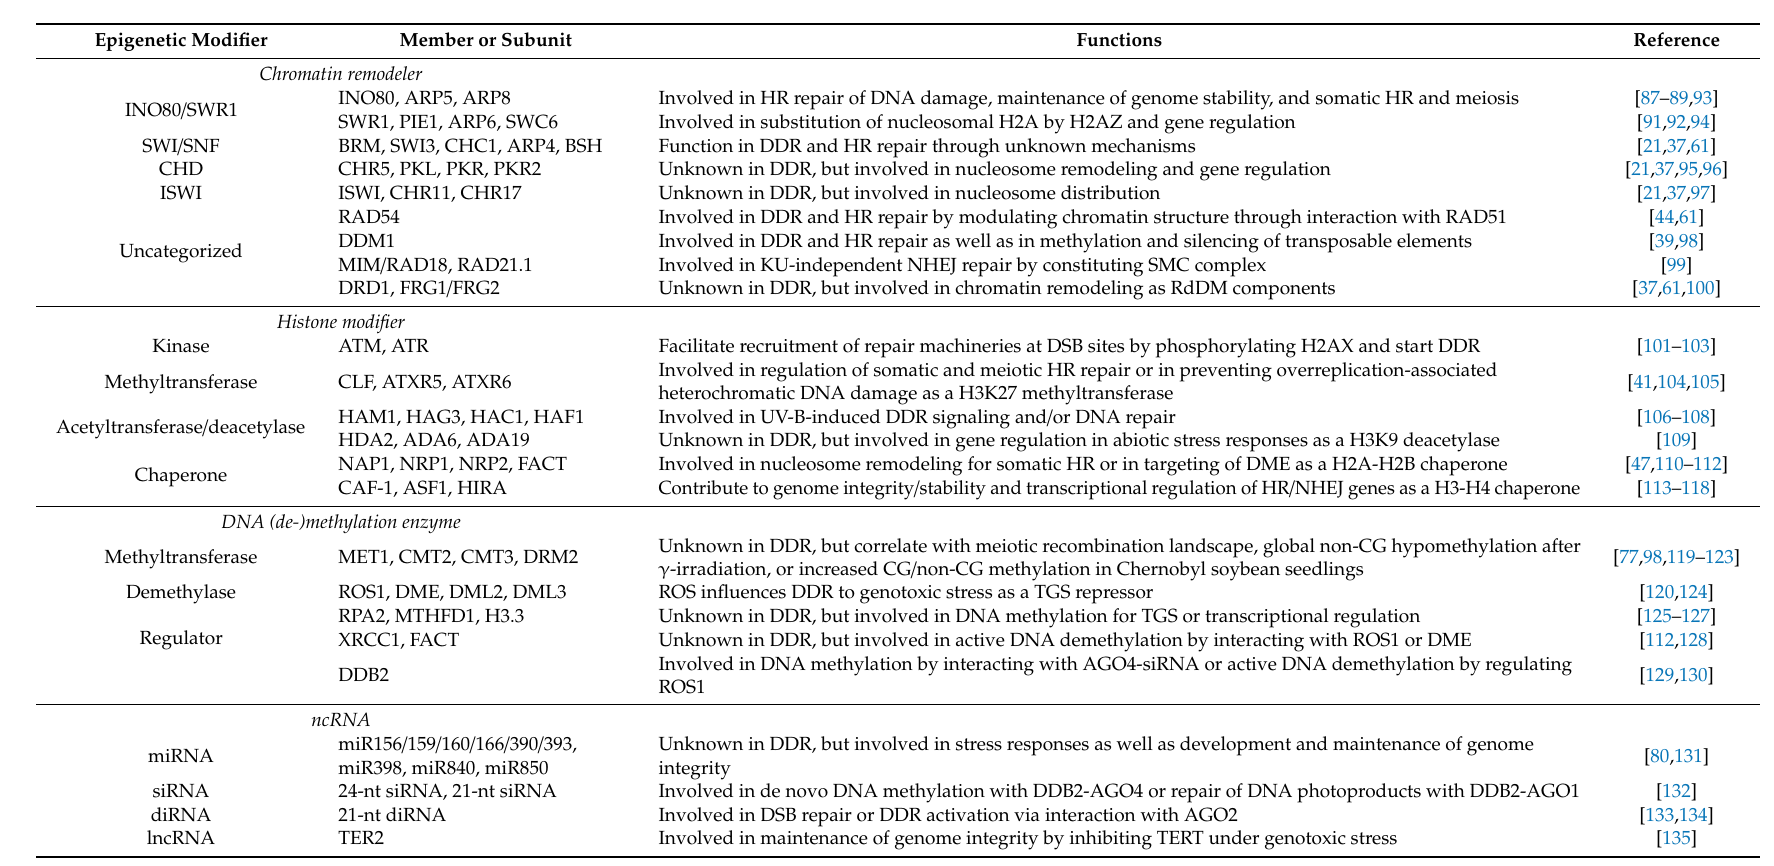
Table 2. Epigenetic modifiers in plant DDR and DNA repair. This summarizes the representative examples for each epigenetic modifier in correlation with DDR or DNA repair in plants. ‘Unknown in DDR’ means that there is no evidence to correlate the epigenetic modifier with DDR in plants, although it may exist in yeasts or